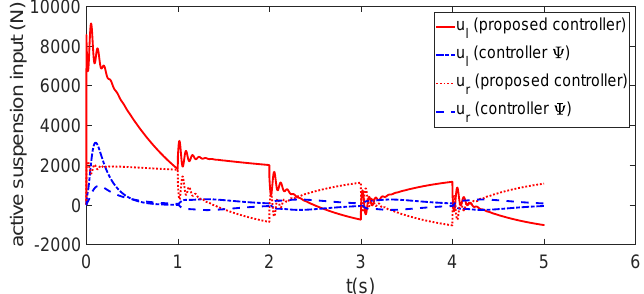
Figure 7. Active suspension input.